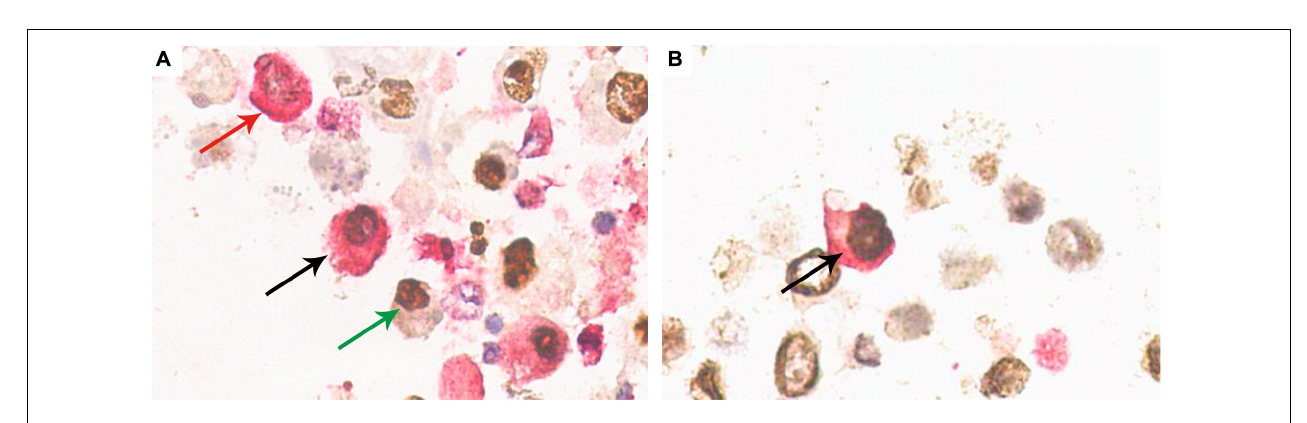
FIGURE 4 | Confirmation of HGD(+)/SV40-T(+) cells and 58K(+)/SV40-T(+) cells on urinary sediment cell blocks by double-immunostaining ( × 400). (A) Double-immunostaining revealed cell with concurrent HGD expression (cytoplasm, red) and SV40-T expression (nuclei, brown) (black arrow), with the background showing single positiveness of either HGD expression in the cytoplasm (red arrow) or SV40-T expression in the nuclei (green arrow). (B) Double-immunostaining revealed a cell with 58K expression (cytoplasm, red) and SV40-T expression (nuclei, brown) (black arrow). 58-kDa Golgi protein (58K); homogentisate 1, 2-dioxygenase